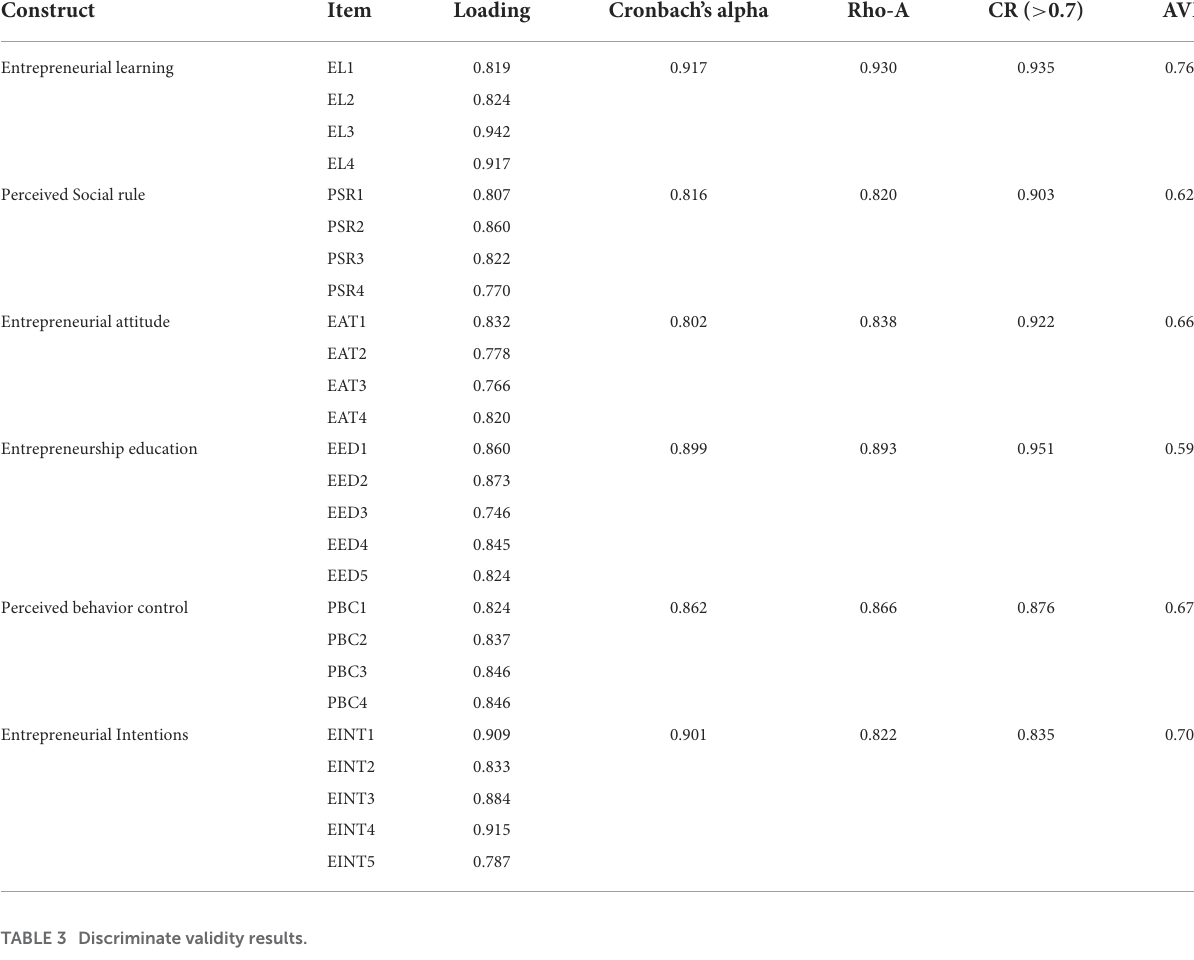
TABLE 2 Results of converging validity.